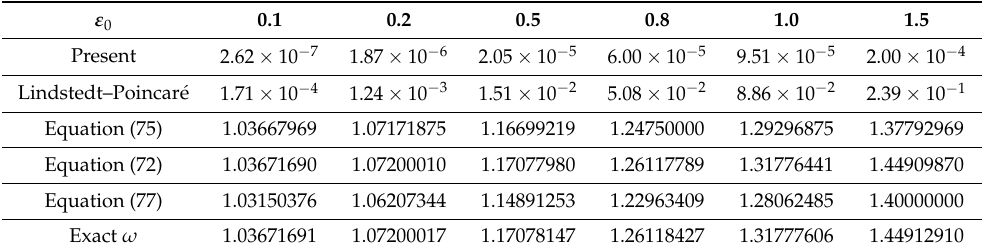
Table 3. The maximum errors (MEs) and frequencies for the analytic solution of Example 3 with different ε 0 . ε